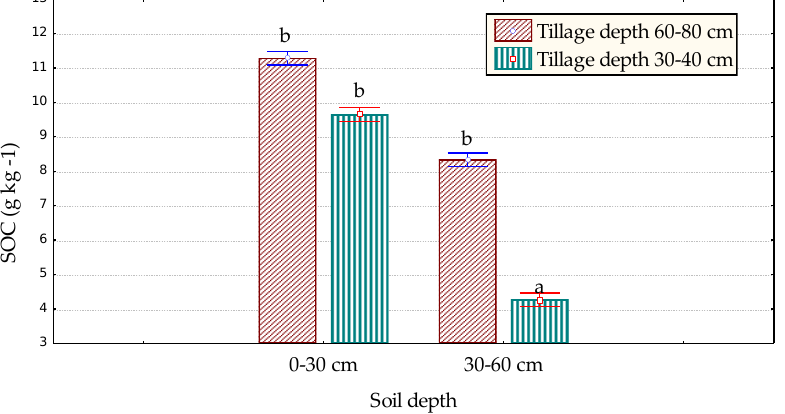
Figure 11. Soil organic carbon (SOC) content in soil layers of vineyards for different tillage depths (N = 60). Significant differences between soil groups are labeled with different letters, p < 0.05.